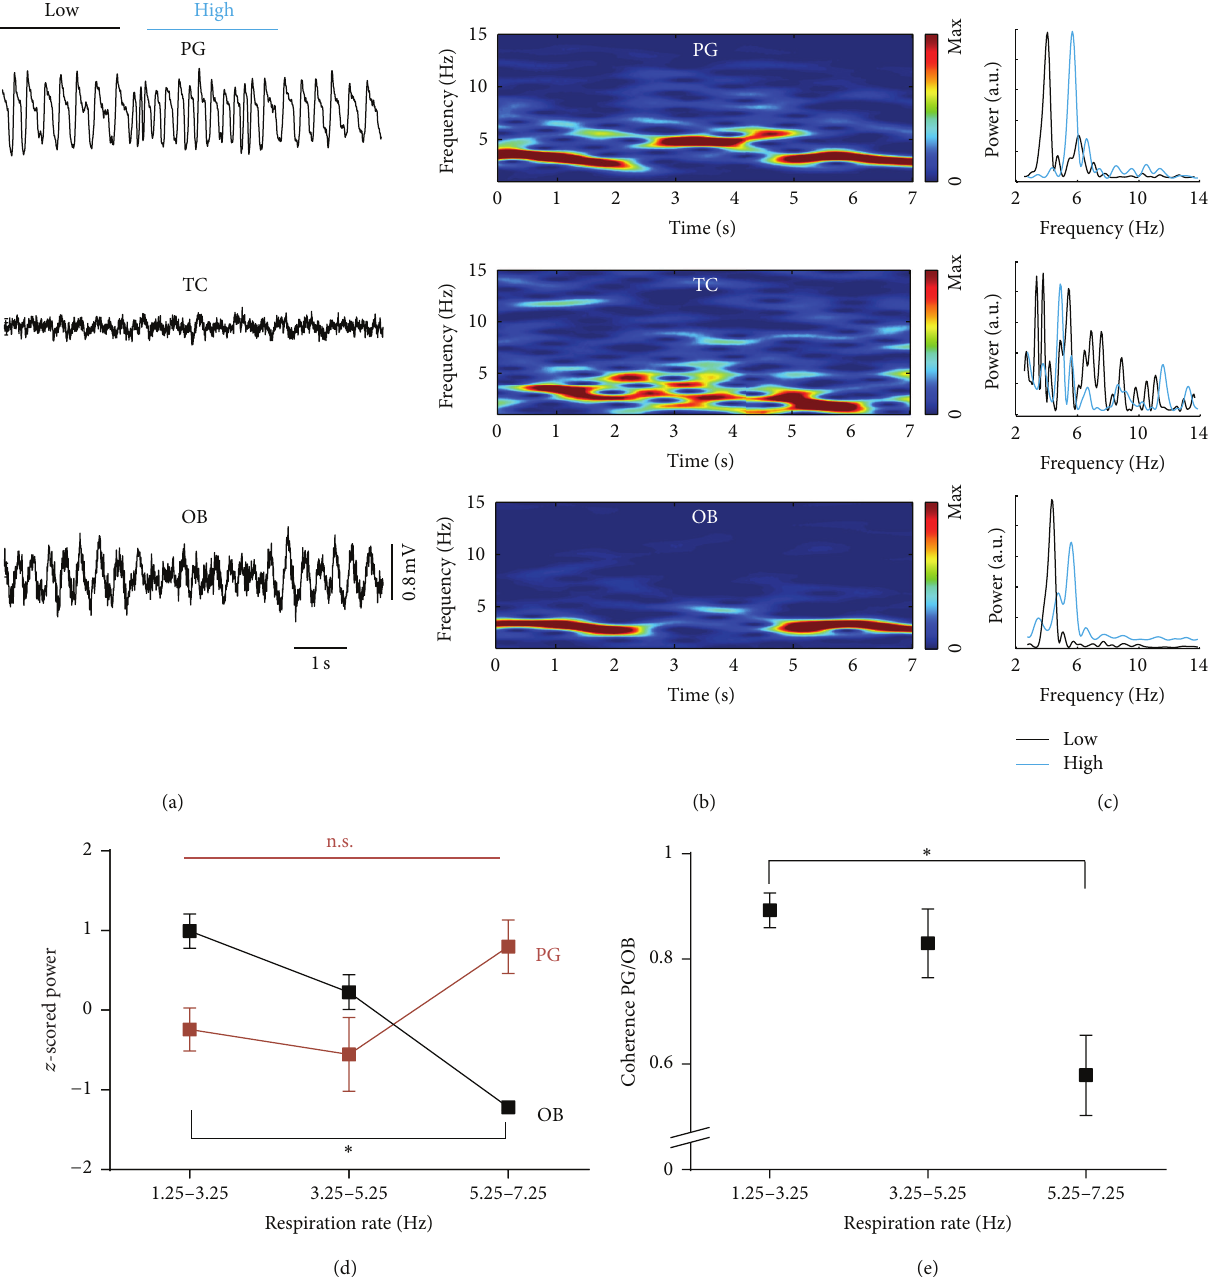
Figure 5: During REM sleep only plethysmography reliably indicates respiration for low and high breathing frequencies. Respiration- entrained local field potentials in olfactory bulb appeared mostly at low breathing frequencies. Thermocouple signal did not contain any respiration-related information. (a) Raw signals of plethysmography (PG), thermosensor (TS), and local field potential of the olfactory bulb (OB). (b) Time-frequency distribution. (c) Power spectral density of the time segments marked in (a). (d) 𝑧 -scored averages of peak power ( ± SEM) of PG (red; 𝑛 = 6 ; 𝑝 = 0.1416 ; Friedman’s test) and the LFP in OB (black; 𝑛 = 6 ; ∗ 𝑝 < 0.01 ; Friedman’s test). (e) Coherence between PG and OB decreased with increasing breathing frequency ( 𝑛 = 6 ; ∗ 𝑝 < 0.01 ; Friedman’s